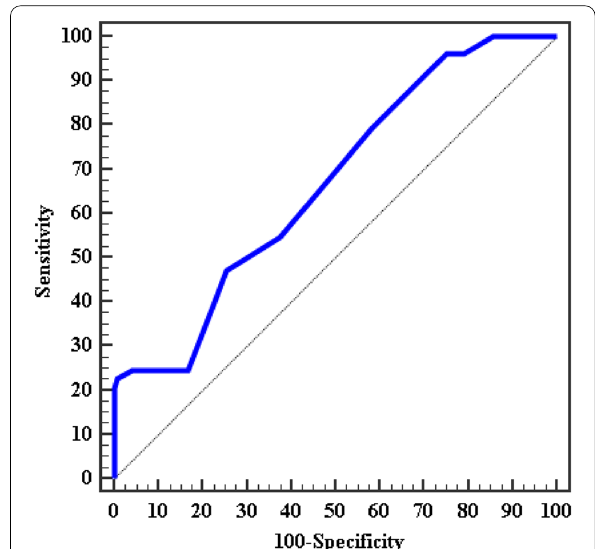
Fig. 1 ROC curve for ALT to diagnose NAFLD patients ( n Cutoff value 19 IU/L, sensitivity 73.58%, specificity 60.80%, and area under the curve 0.731 (95% CI 0.653–0.809)